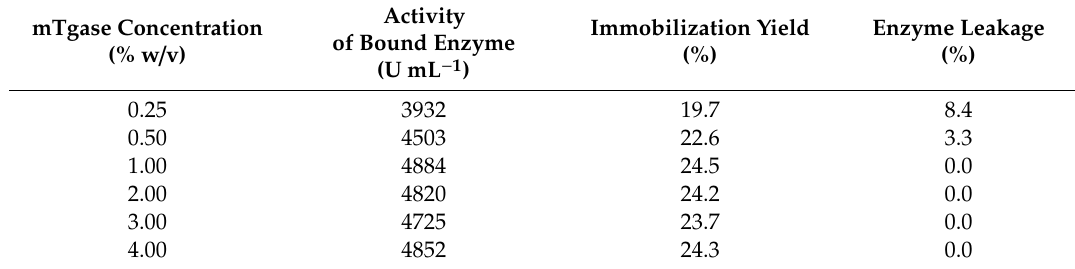
Table 6. E ff ect of the concentration of microbial transglutaminase (mTGase) on invertase immobilization in gelatin-based hydrogel.